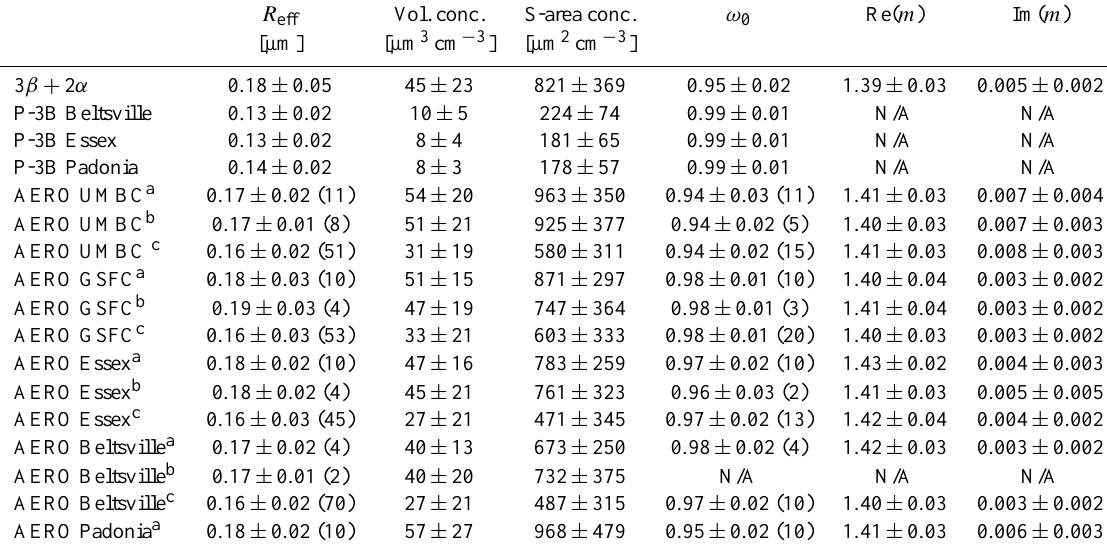
Table 2. Average of results obtained from lidar retrievals (i.e., 3 β + 2 α ) and in situ measurements from P-3B flights, and AERONET retrievals of effective radius ( R eff ), volume and surface-area concentrations, and single-scattering albedo. Real and imaginary parts of the complex index of refraction were compared to AERONET only. Maximum aerosol layer height (AHL) was assumed to be 1.5km in order to convert AERONET volume and surface-area concentrations from per unit area to per unit volume. Mean values from AERONET are presented for three different averaging subsets. Number of data points for each subset is presented between parentheses for size- and optical-related parameters. R eff Vol.